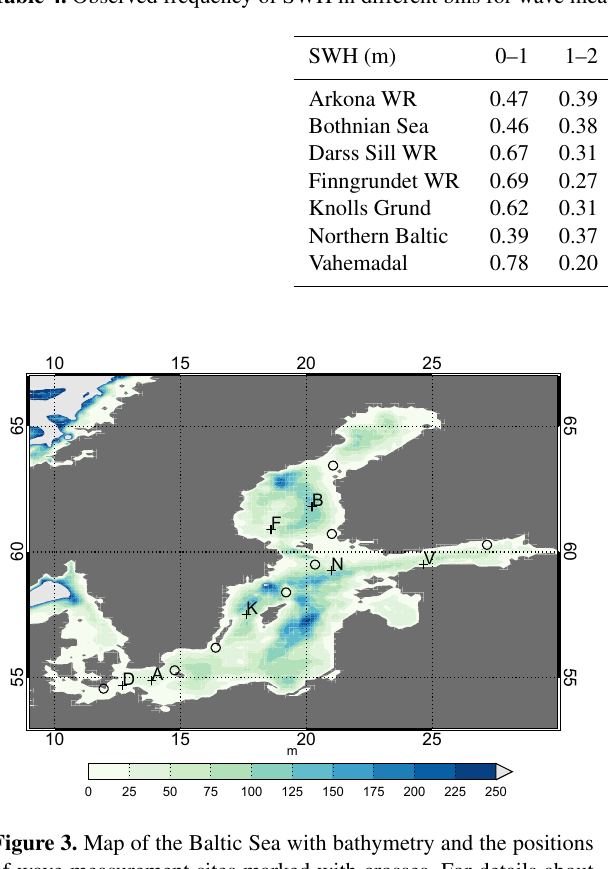
Figure 2. Forecasted (48h) SWH at the peak of the “Toini” storm 10 January 2017 00:00Z for the LOW (a) , LOWENSMEAN (b) and HIGH (c) forecasts. Table 4. Observed frequency of SWH in different bins for wave measurement sites.